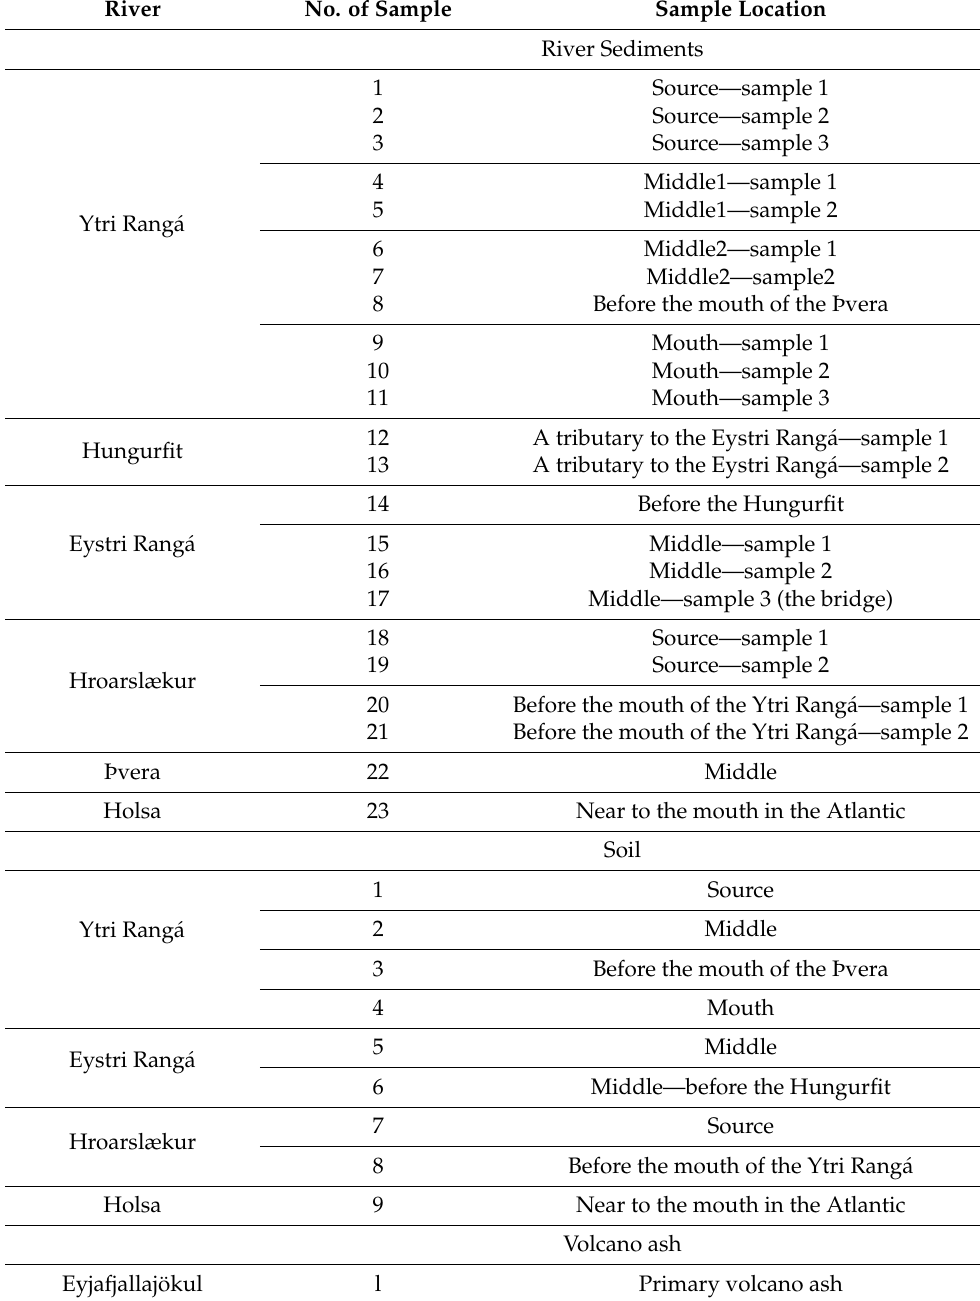
Table 1. Location of samples collected in the Rang á rvellir